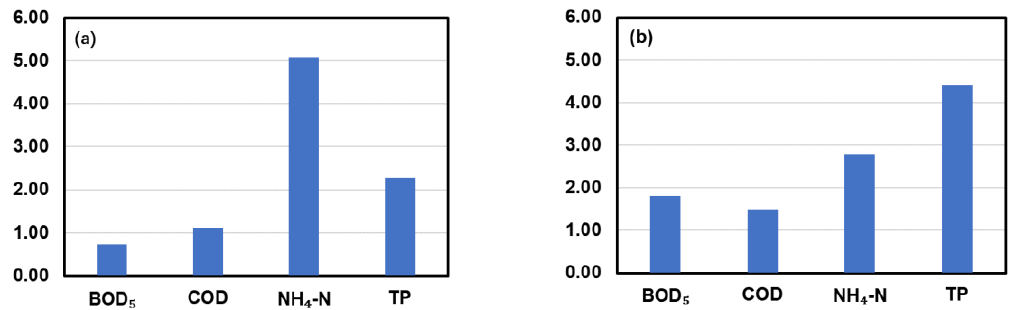
Figure 7. Ratios of water quality values measured in April, 2018 to the ones measured from our samples at ( a ) WK09 and ( b ) XDY06.